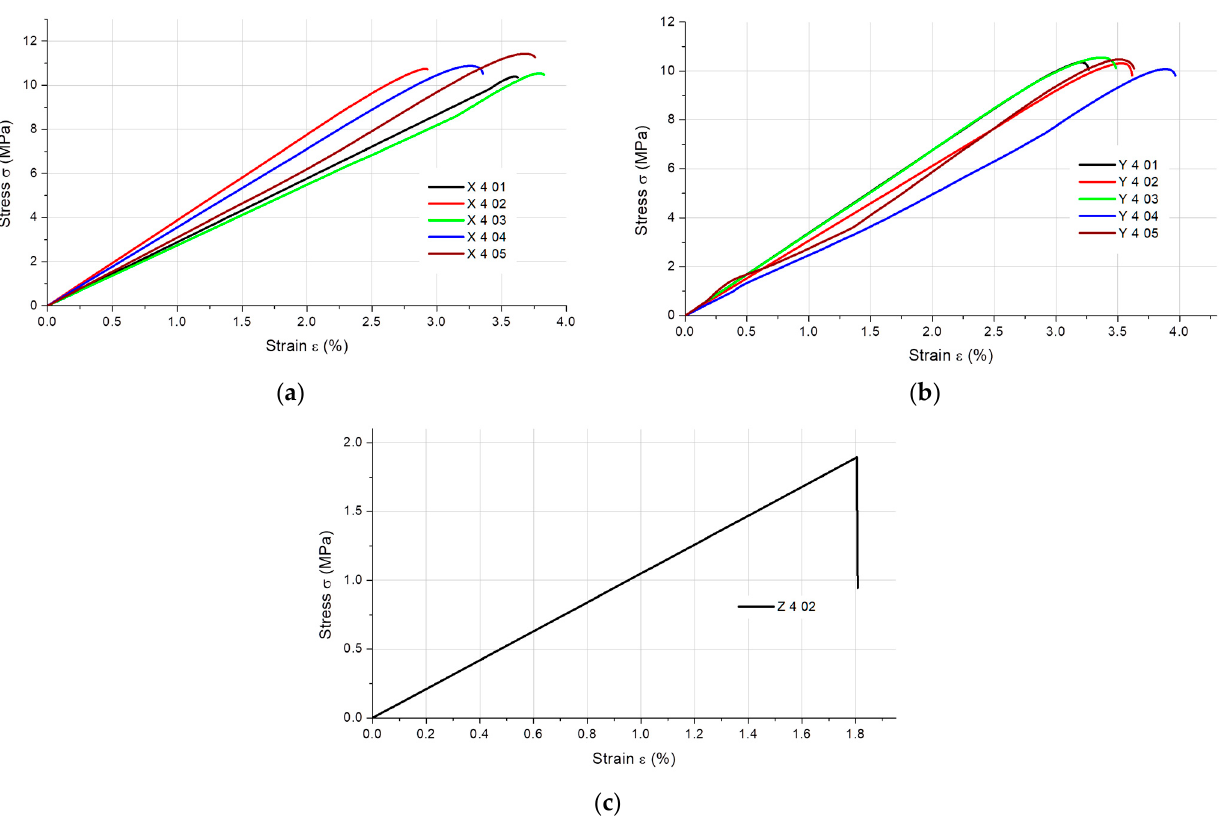
Figure 5. Stress–strain curves for the 4 mm thick specimens composed of PLA + bronze printed in ( a ) the X orientation, ( b ) the Y orientation and ( c ) the Z orientation (only one specimen tested). The ultimate tensile strength, R m , and the maximum elongation at failure in %, ε m , which occurred under the maximum tensile loading, reported for the PLA + bronze com- posite specimens, are shown in Table 3. Table 3. Ultimate tensile strength and the maximum elongation at failure in % for the PLA + bronze